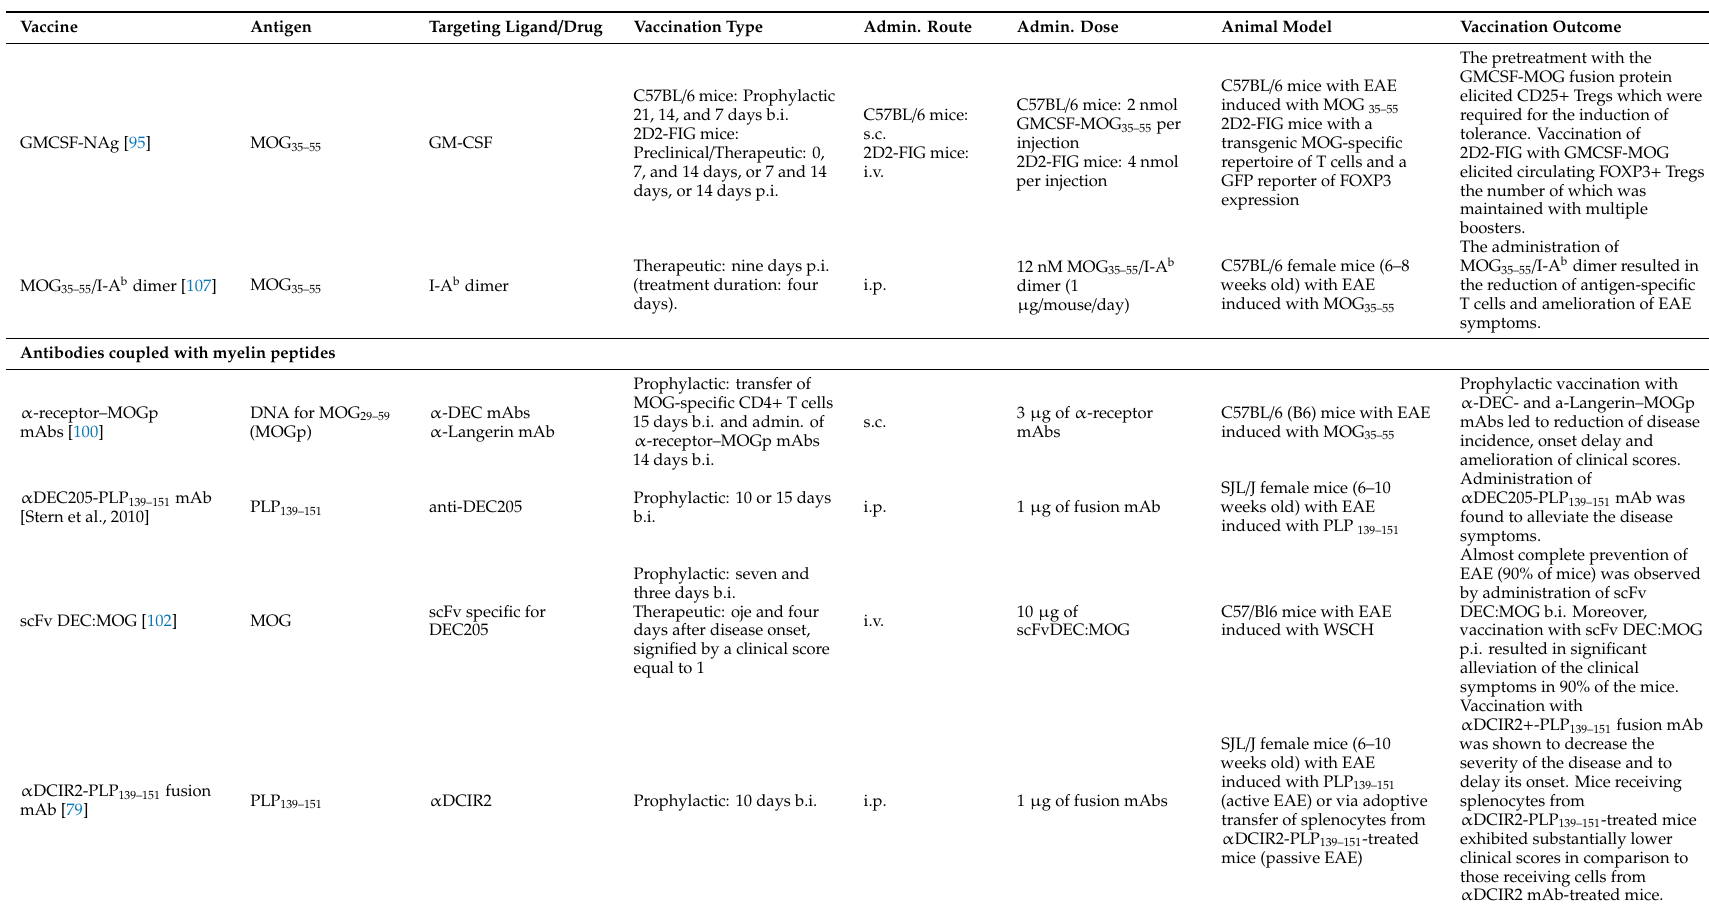
2D2-FIG mice: Preclinical / Therapeutic: 0,